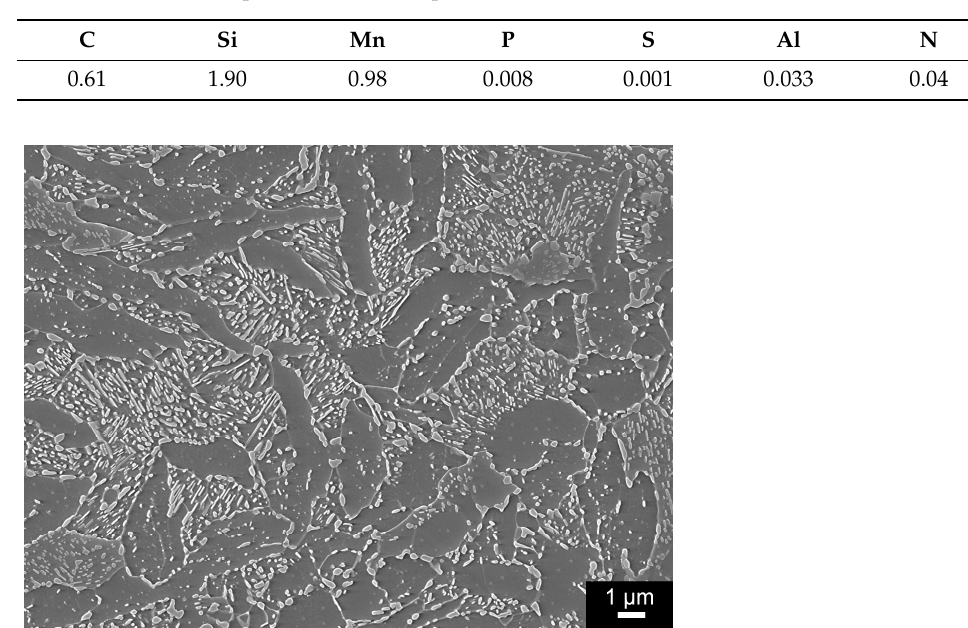
Table 1. Chemical composition of the sample in mass%.